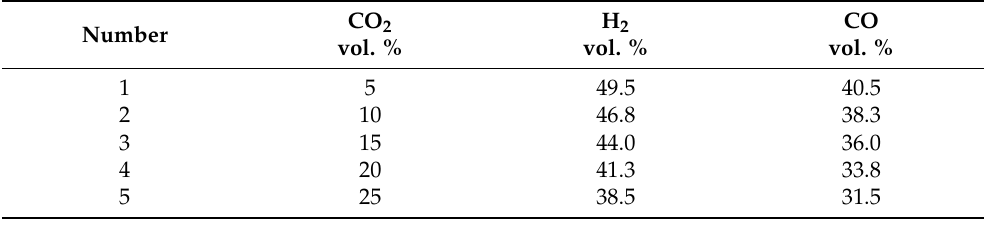
Figure 2. The fluid domain grid. (a shows the mesh contour of the fluid domain, b shows the mesh on the central section of the fluid domain, c shows a detailed view of the mesh in the dashed box of the combustion chamber region, d shows a detailed view of the mesh in the dashed box of the air–fuel mixing region.)